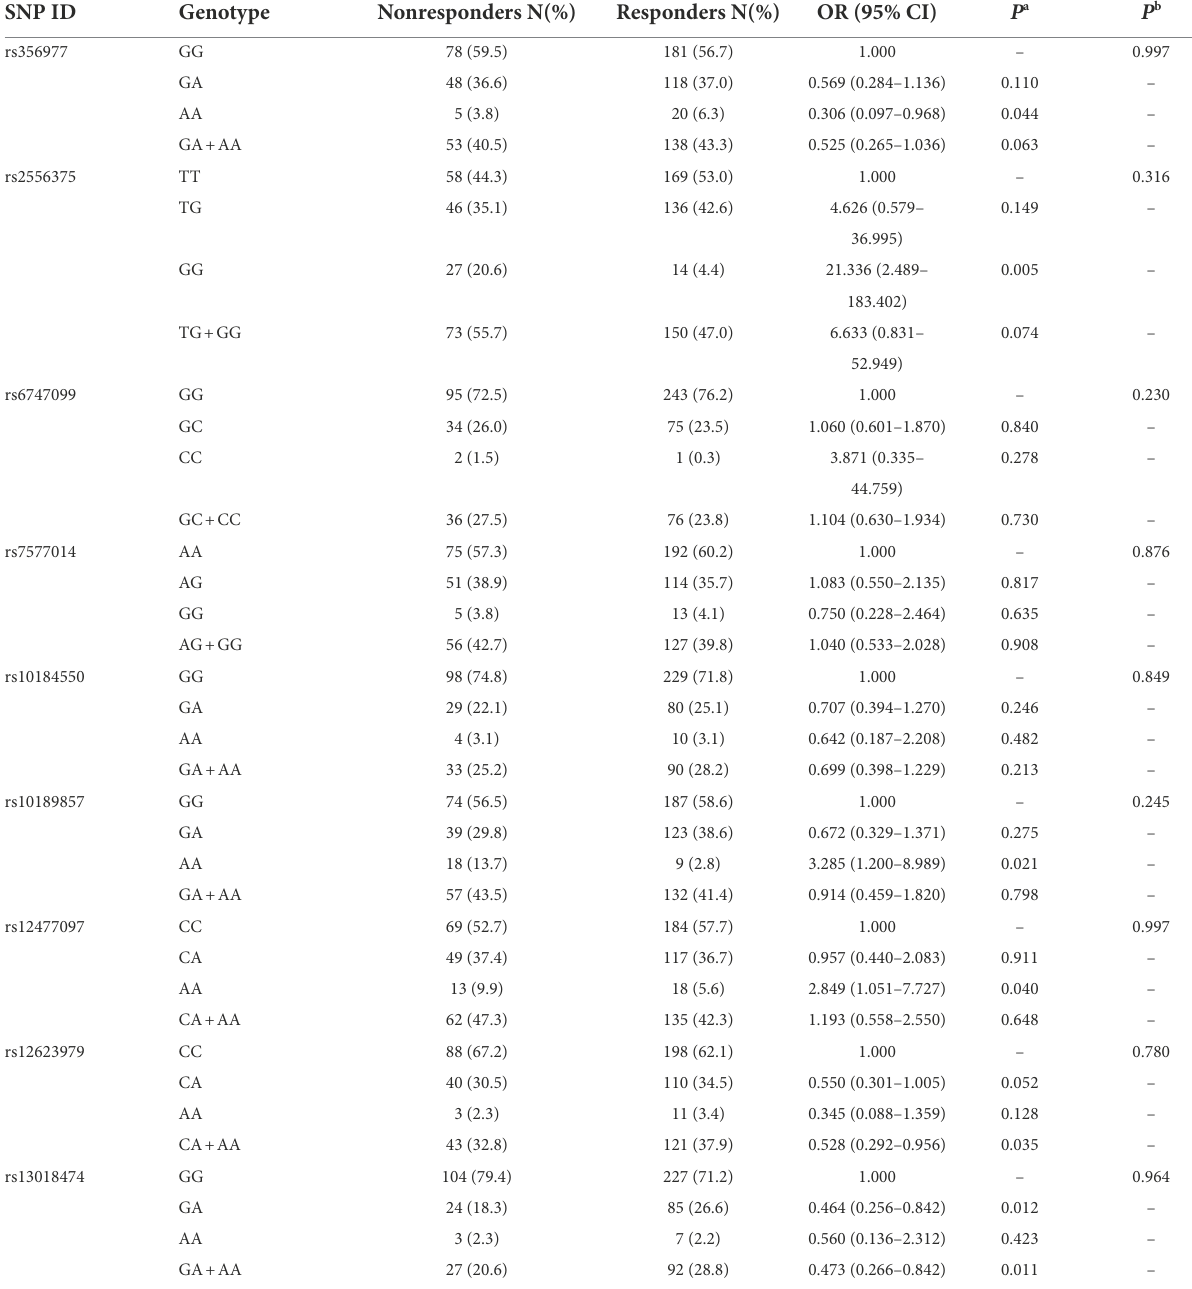
TABLE 3 Associations between BCL11A SNP genotypes and therapeutic response of patients with epilepsy.